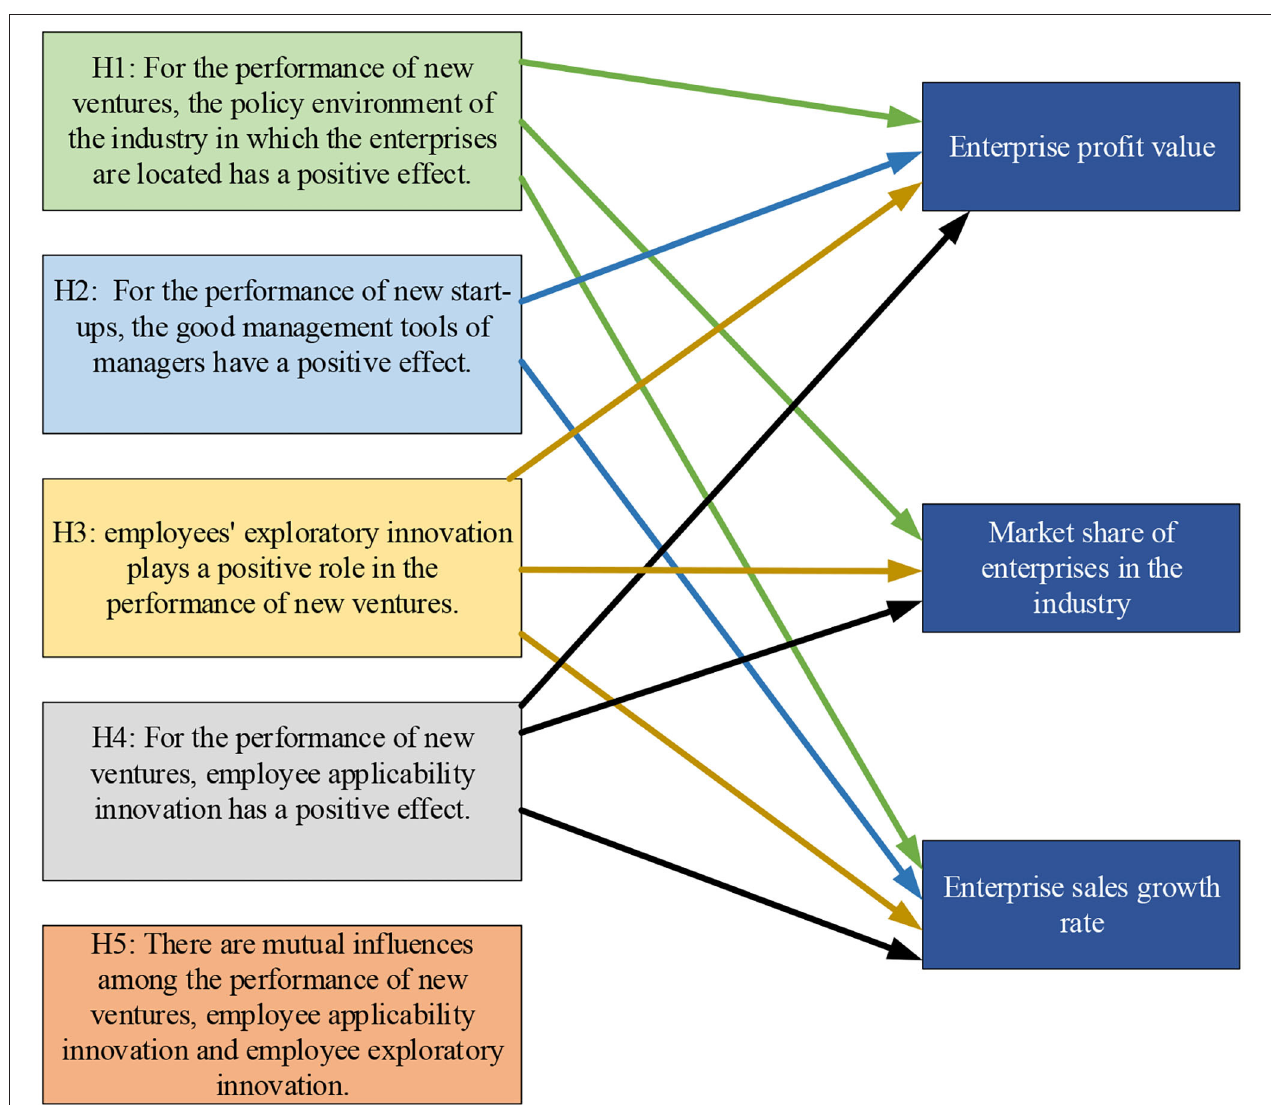
FIGURE 6 | Block diagram of hypothetical results of various influencing